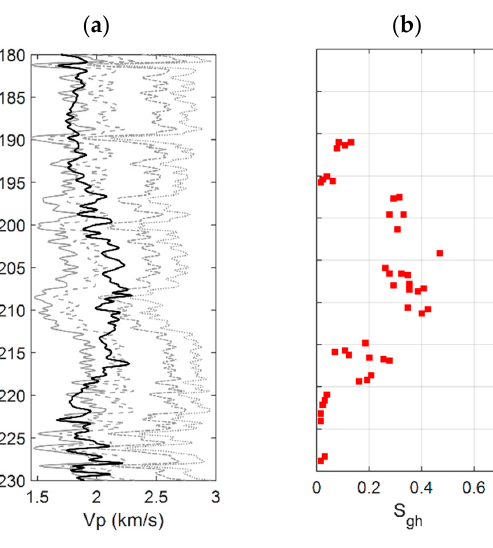
Figure 8. Log data from ( a ) SH2 well and ( b ) SH17 well, including gamma ray, resistivity, P-wave velocity ( V P ), porosity ( φ ), and density ( ρ ).